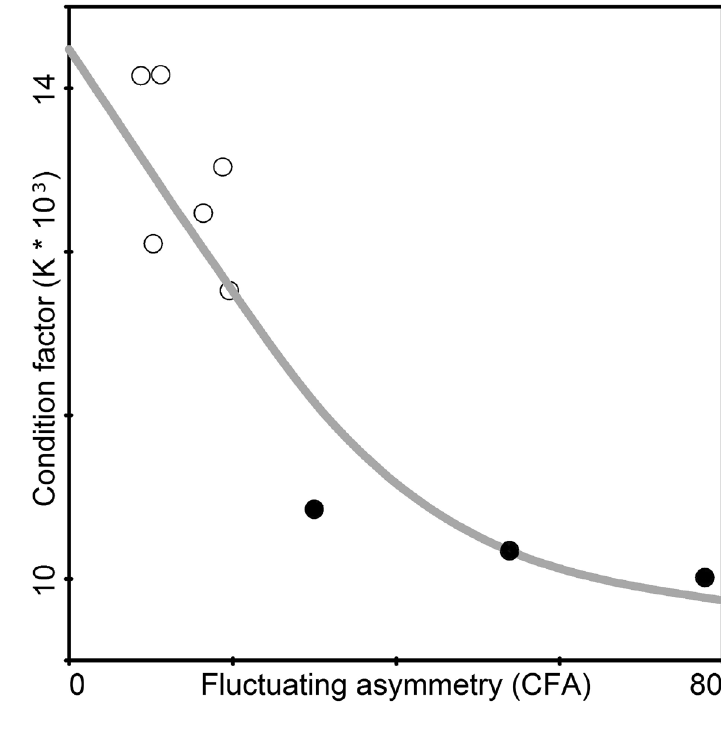
Figure 4. Generalized Additive Model (GAM) selected by Akaike information criterion (AIC) showing the relationship of fluctuating asymmetry (CFA) with condition factor (K) for males of O. ruber